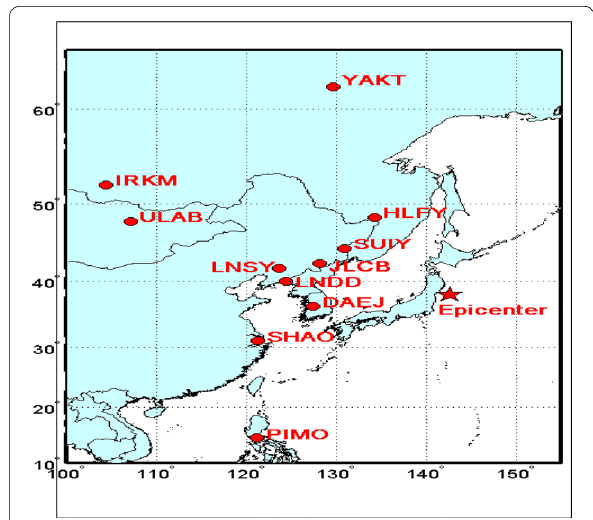
Fig. 4 GNSS stations to the west of Japan